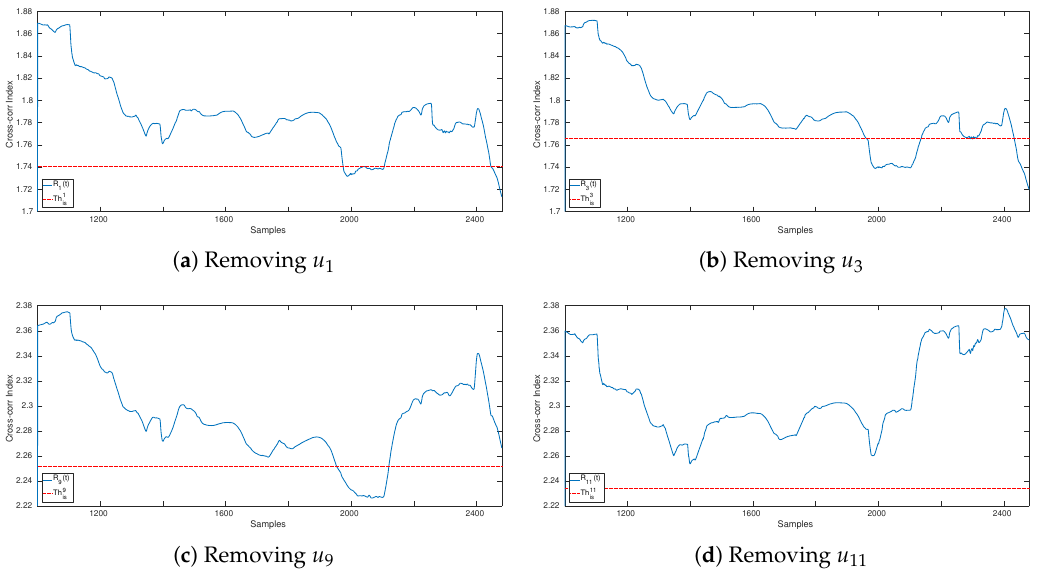
Figure 6. An example of isolation when the attacked sensor is u 11 : The detection has been raised by sensor u 9 at time (cid:98) t = 2481. The first 1000 samples belong to the training sequence, i.e., S = 1000. In the legends, the symbol Th i is corresponds to Θ i in the is